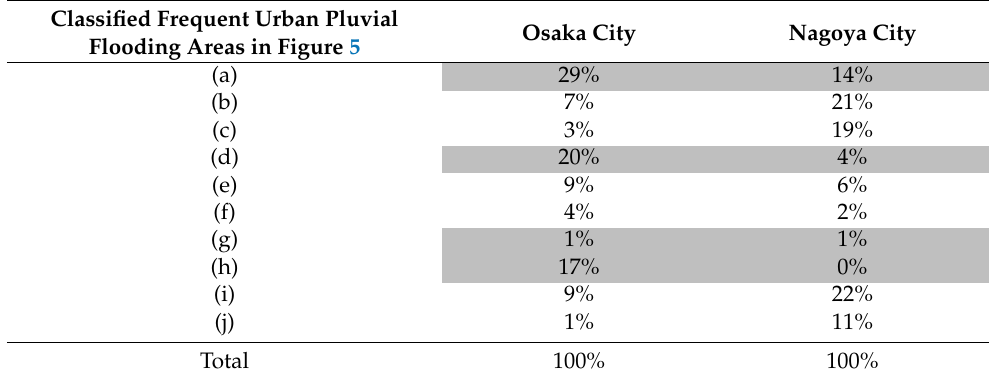
Figure 5. A conceptual diagram of the classification conditions of the classified frequent urban pluvial flooding areas. ( a – h ) are areas where “dominant structures” were located within 8 mesh around the urban pluvial flooding area, while ( i , j ) are areas where “dominant structures” were not located within 8 mesh around the urban pluvial flooding area. ( h ) is the area where “dominant structures” were located in three directions around the frequent urban pluvial flooding area, and “dominant structures” were located in the front of the slope direction. The red line enclosure are areas where “dominant structures” was located in the direction of inclination (direction of inundated water flow). Table 6. The proportions of the classified frequent urban pluvial flooding areas in Figure 5. The grey values are areas where “dominant structures” were located in the direction of inundated water flow.